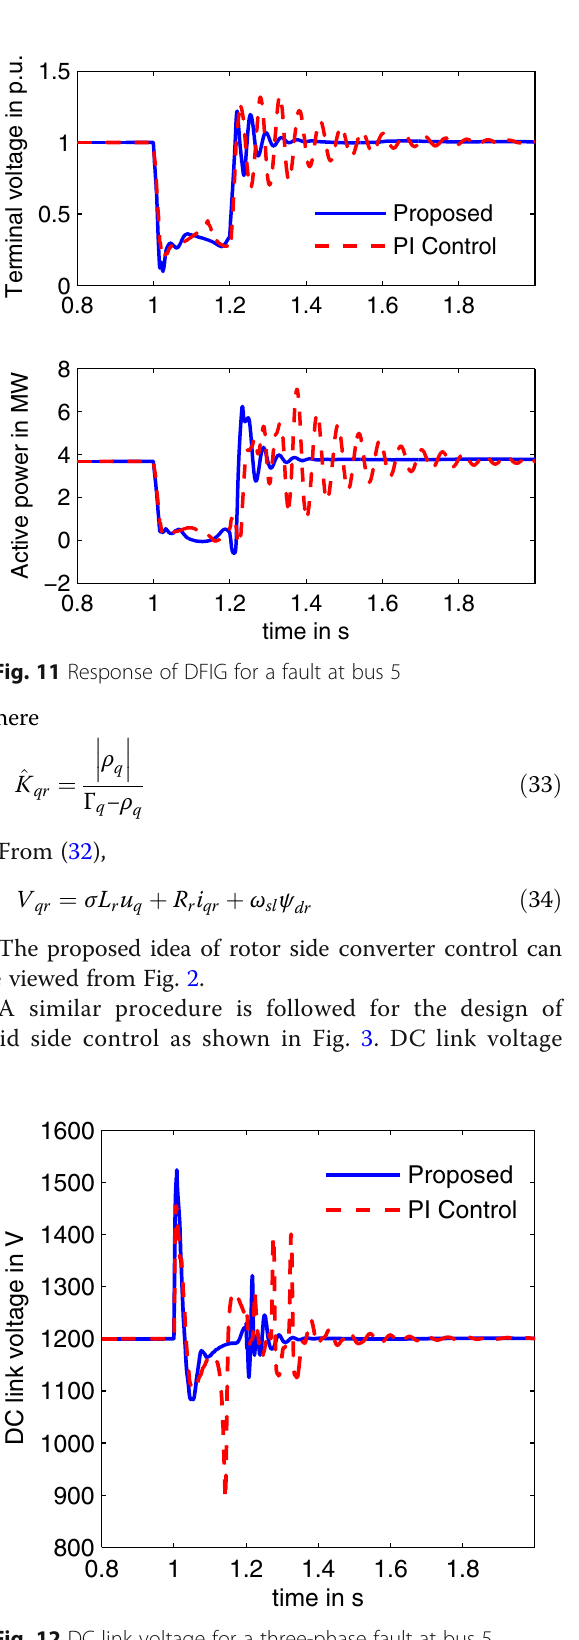
Fig. 12 DC link voltage for a three-phase fault at bus 5